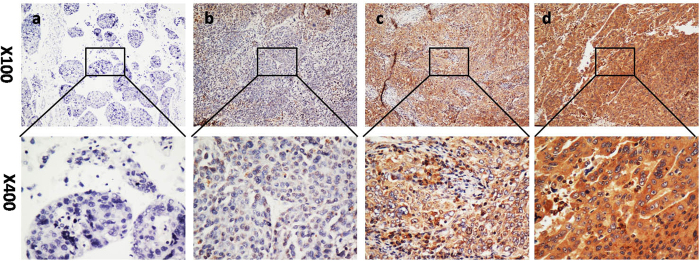
The protein expression of GNA13 in HCC by immunohistochemistry.The representative images show different staining intensities of GNA13: (a) negative staining, (b) weak staining, (c) moderate staining, and (d) strong staining (original magnification, x100 and x400).